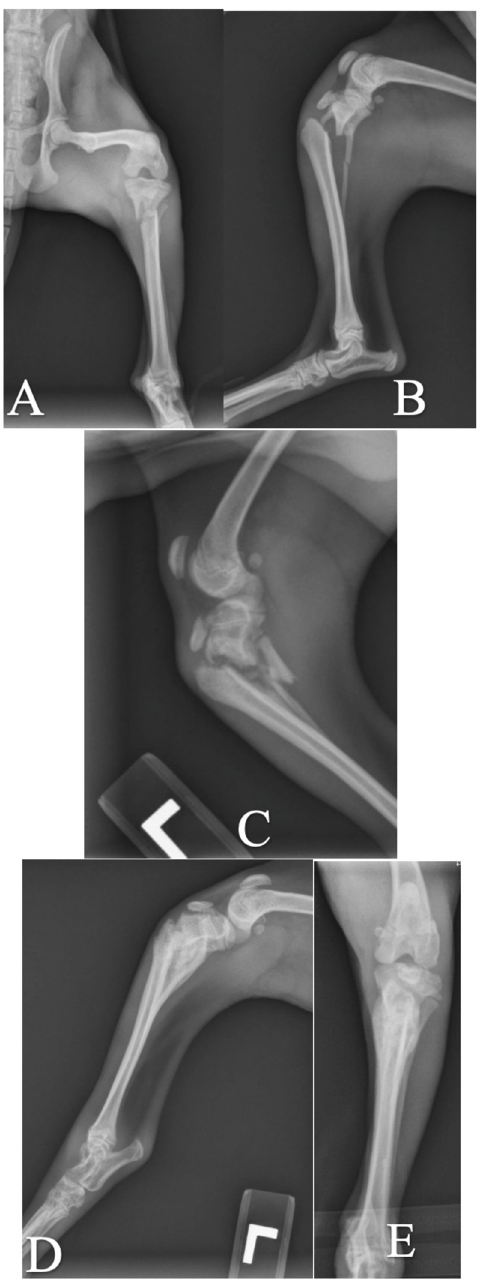
Fig 7. Case 40a managed with a splint bandage alone. A and B: Mediolateral and craniocaudal views at time of injury. C: Mediolateral view 2 weeks post injury. D and E: Mediolateral and craniocaudal views 6 weeks post injury demonstrating excessive TPA that can result from treatment with external coaptation